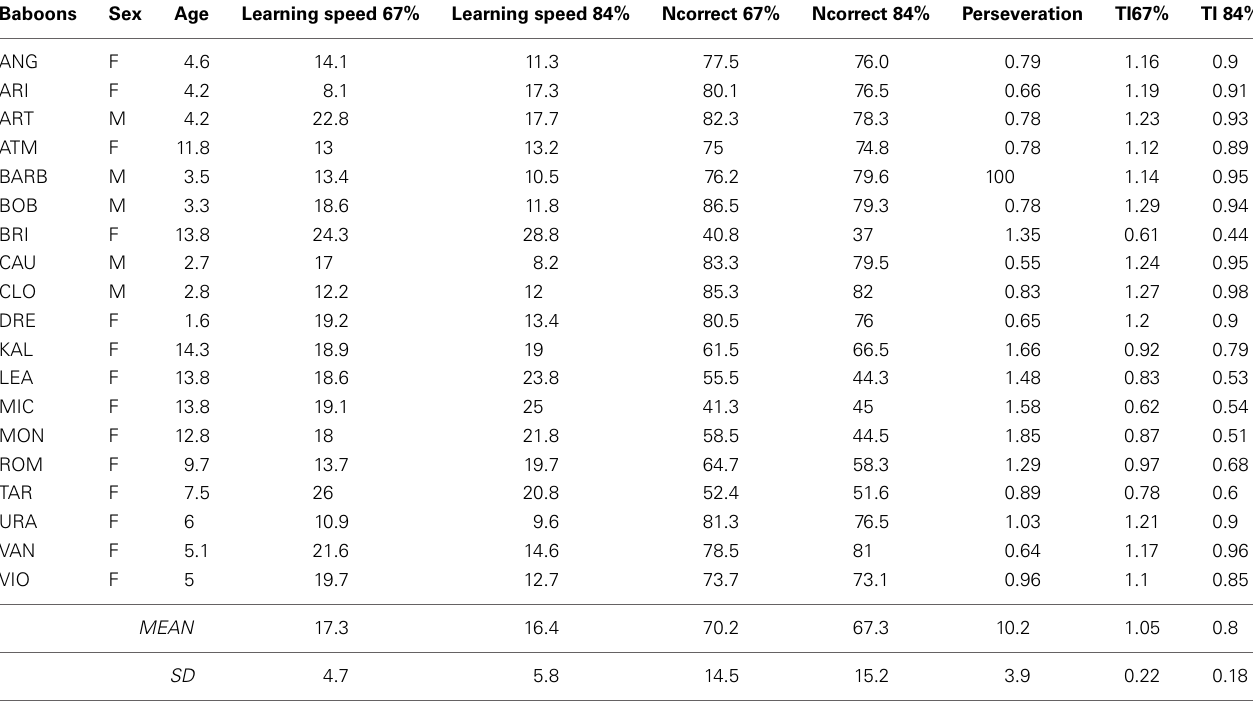
This table indicates, for each subject and training criterion, the mean number of trials required to reach each criterion (learning speed), the corresponding mean percentage of post-reversal correct responses, the mean number of perseveration trials, and the TI value.